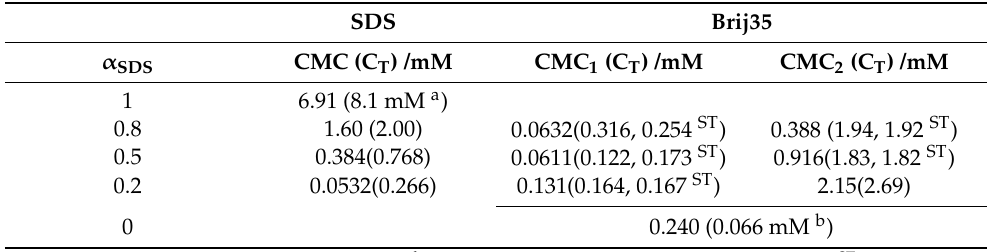
Table 1. CMC values of SDS and Brij35 in mixed systems at different molar ratios of SDS ( α SDS